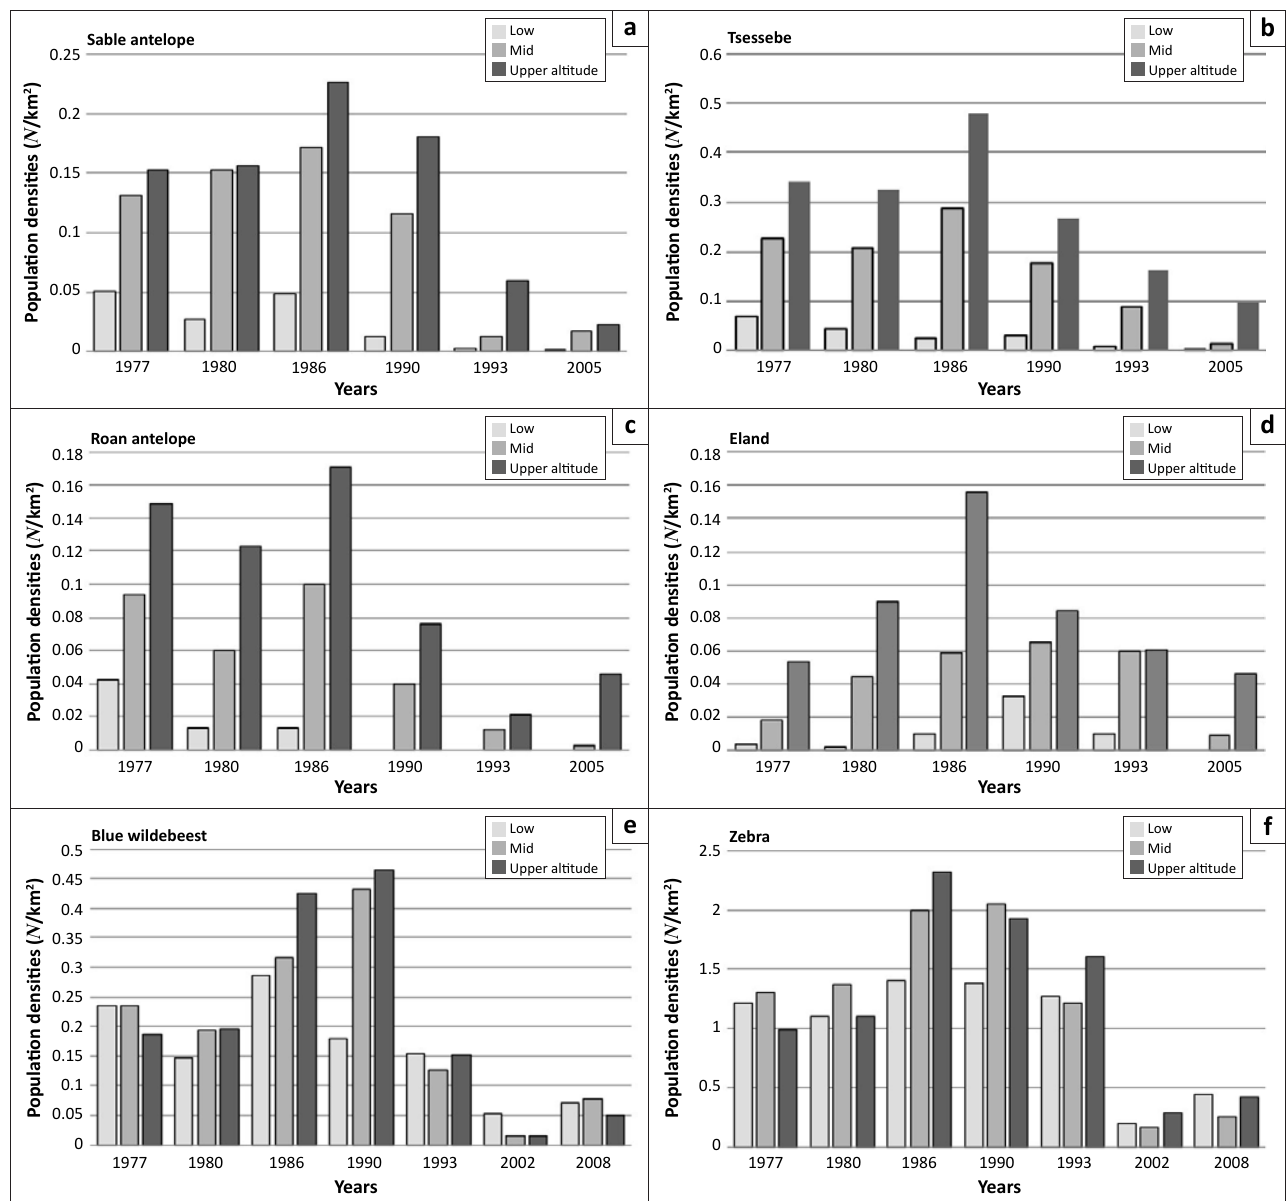
FIGURE 9: Population densities of four selective grazers, (a) sable antelope, (b) tsessebe, (c) roan antelope, (d) eland and two large herbivore species selecting for nitrogen–quality patches, (e) blue wildebeest and (f) zebra in the Kruger National Park (1977–2005 or 2008) differentiated over three altitude